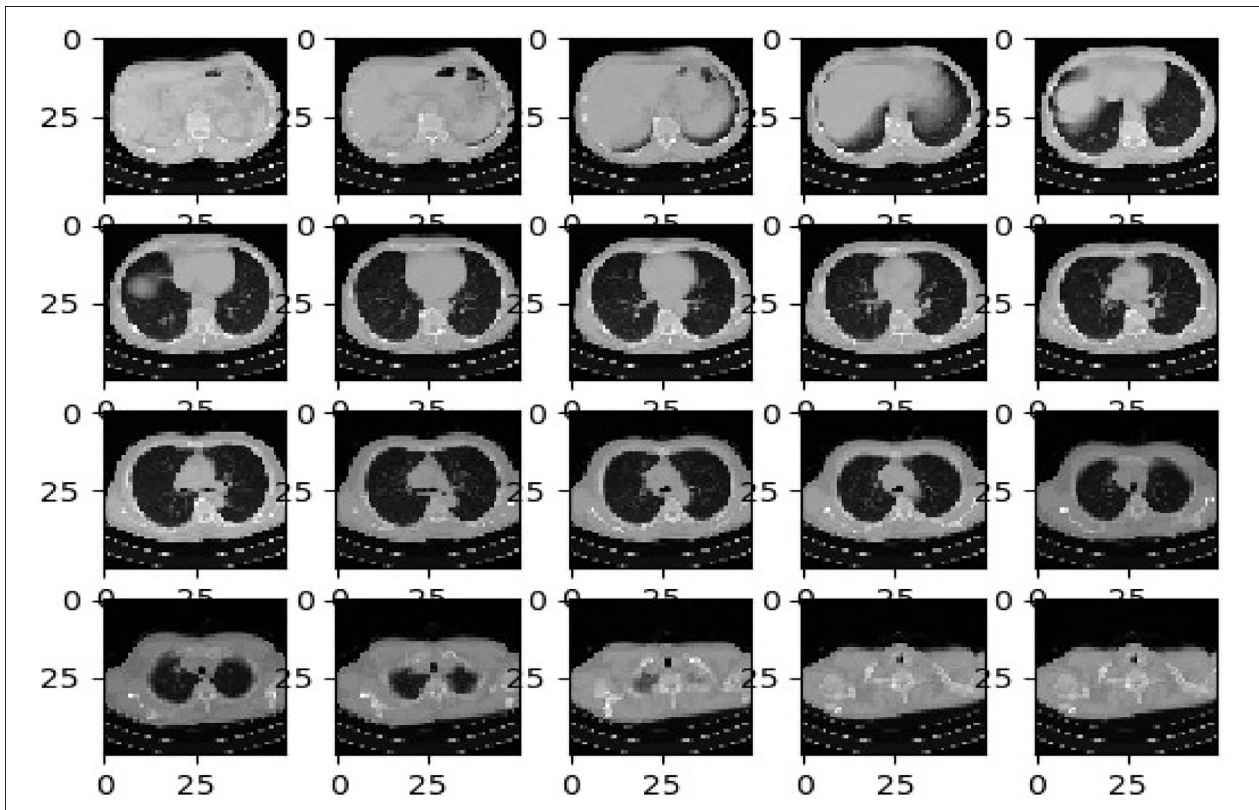
FIGURE 2 | Computed tomography specimen images—Dataset-1.